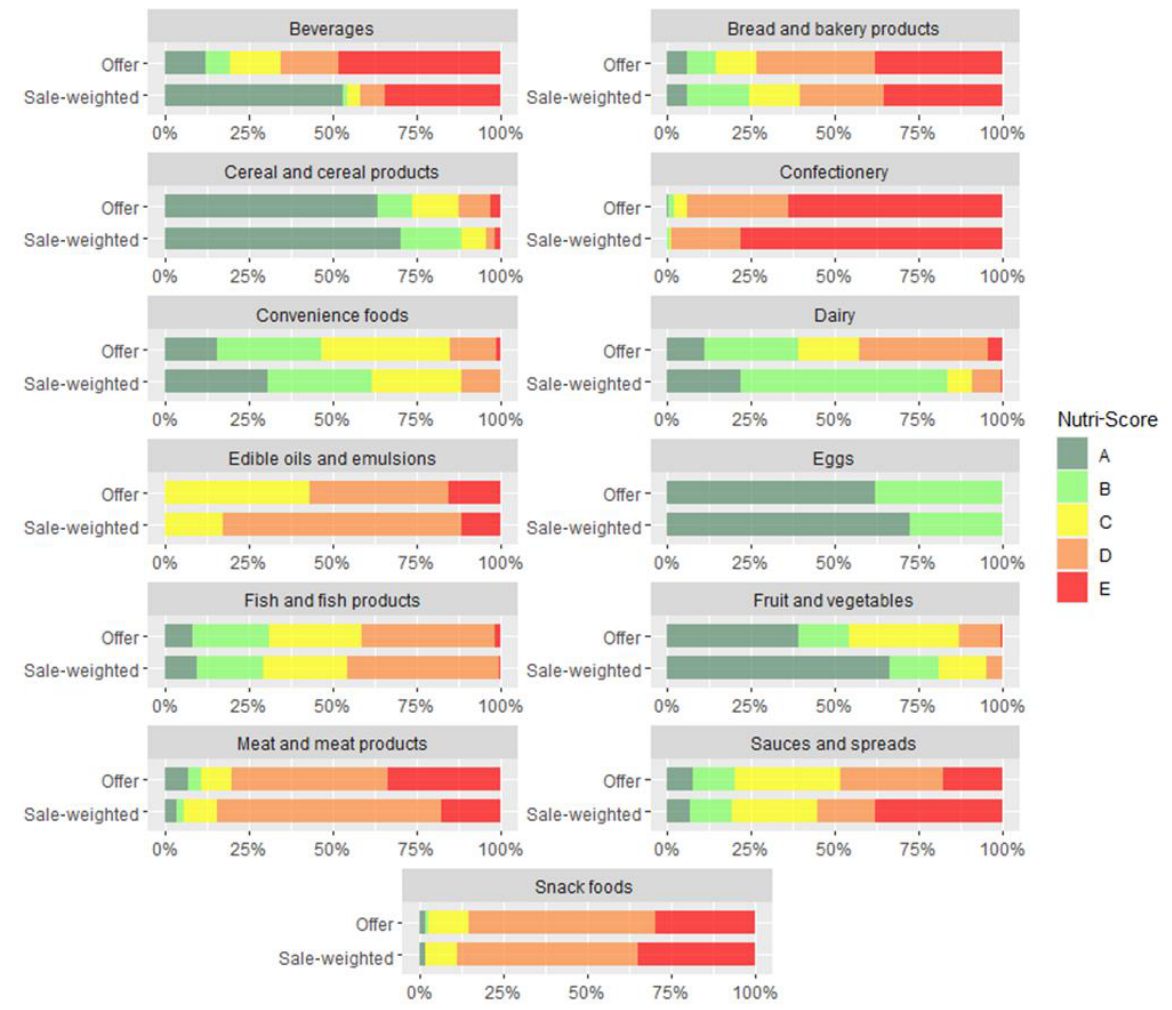
Figure 4. Distribution of Nutri-Score grades across main categories using sale-weighting ( n = 10,402). Letters from A to E represent five Nutri-Score grades.